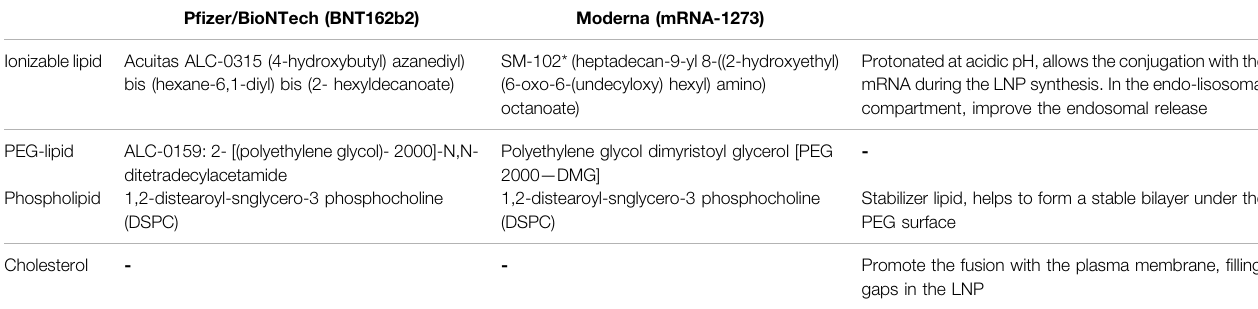
TABLE 1 | Lipid components in mRNA vaccines manufactured by P fi zer/BioNTech and Moderna. P fi zer/BioNTech